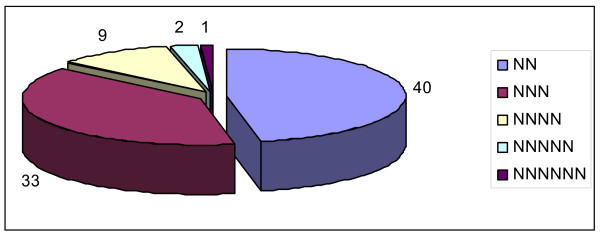
EST-SSR motifs derived from pigeonpea unigenes (UG-IV). Number of EST-SSR repeat motifs (excluding monomers) derived from unigenes (UG-IV) of pigeonpea cDNA libraries subjected to FW and SMD stress.